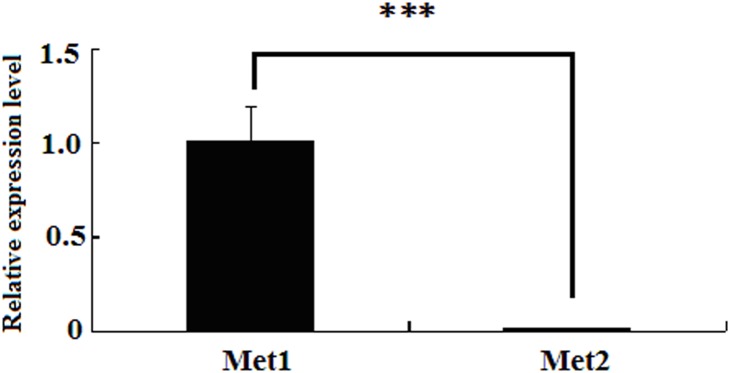
The relative expression level of two Met genes in PGs.PGs of newly emerged females were dissected, and total RNA was extracted for qPCR analysis. Rp49 gene was used as the housekeeping gene for normalization. The data represent the mean values ± SE of three biological replicates. Significance of comparisons are marked with *** (p<0.01) as determined by the Student’s t-test.